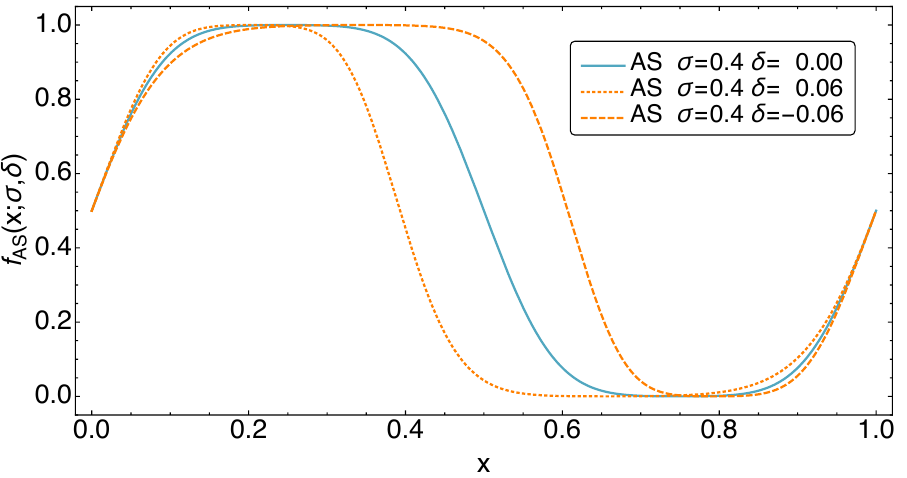
( x ; σ , δ ) of the AS motion class for three values of the shape Figure 3. The defining function f AS parameter δ . This parameter controls the time fraction spent above and below 1/2. Equal times spent within both regions are found at δ =